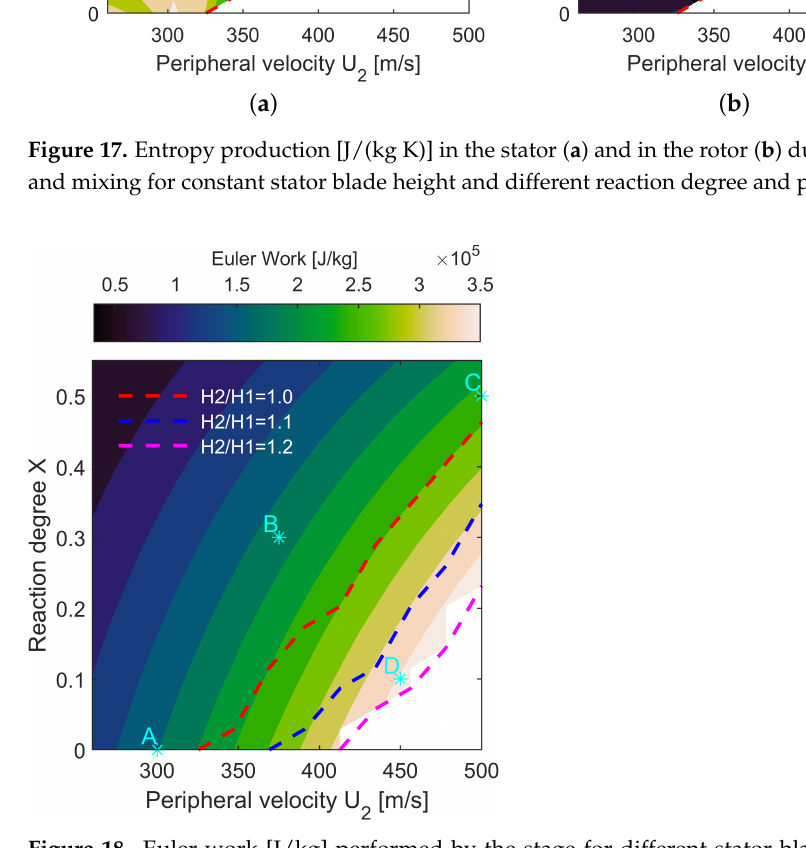
Figure 18. Euler work [J/kg] performed by the stage for different stator blade height, different reaction degree and peripheral